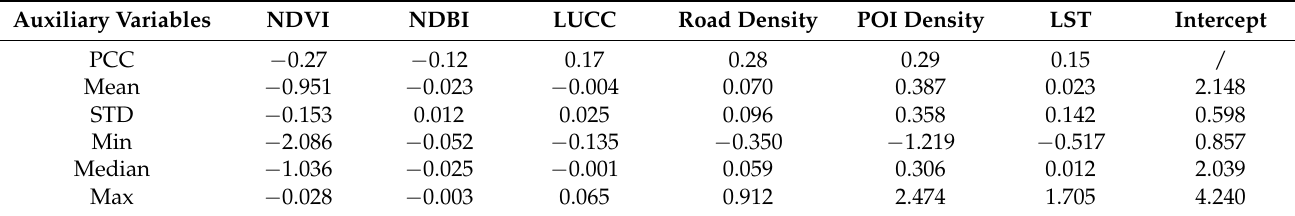
Table 3. Statistics of regression coefficients for MGWR